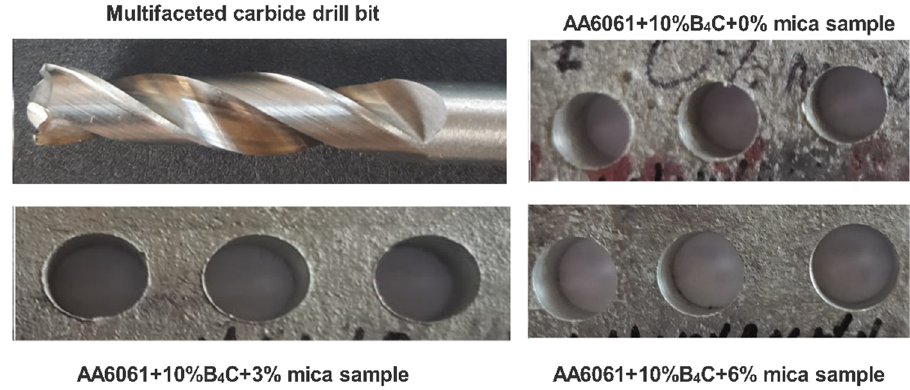
Figure 2. Drill tool and drilled samples of different compositions.